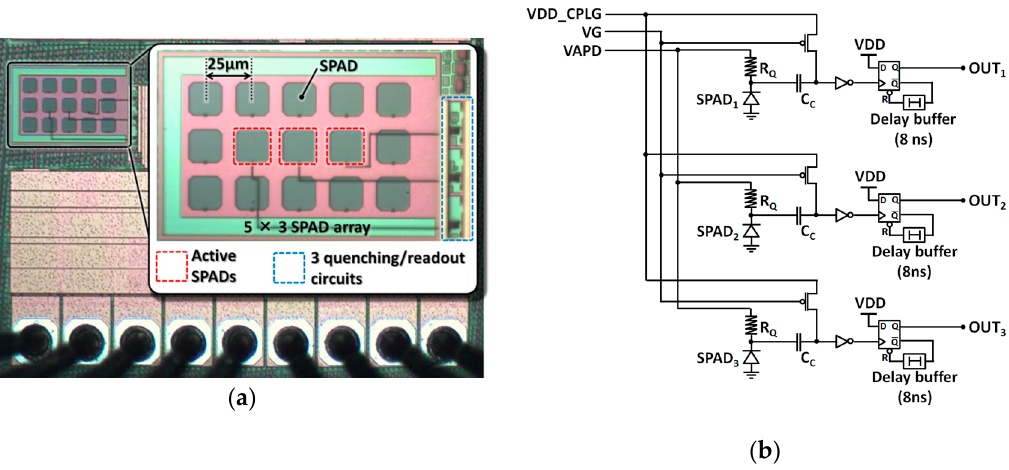
Figure 2. ( a ) Photomicrograph of a sample chip containing an array of 5 × 3 SPADs and three quenching/readout circuits. Only the innermost three SPADs are connected to the circuits. The remaining 12 SPADs are used as “dummy” devices; ( b ) a schematic of three quenching and readout circuits containing SPADs.